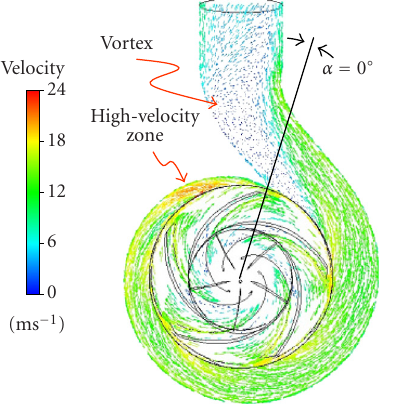
Figure 12: Relative positions between blade trailing edge and volute tongue.